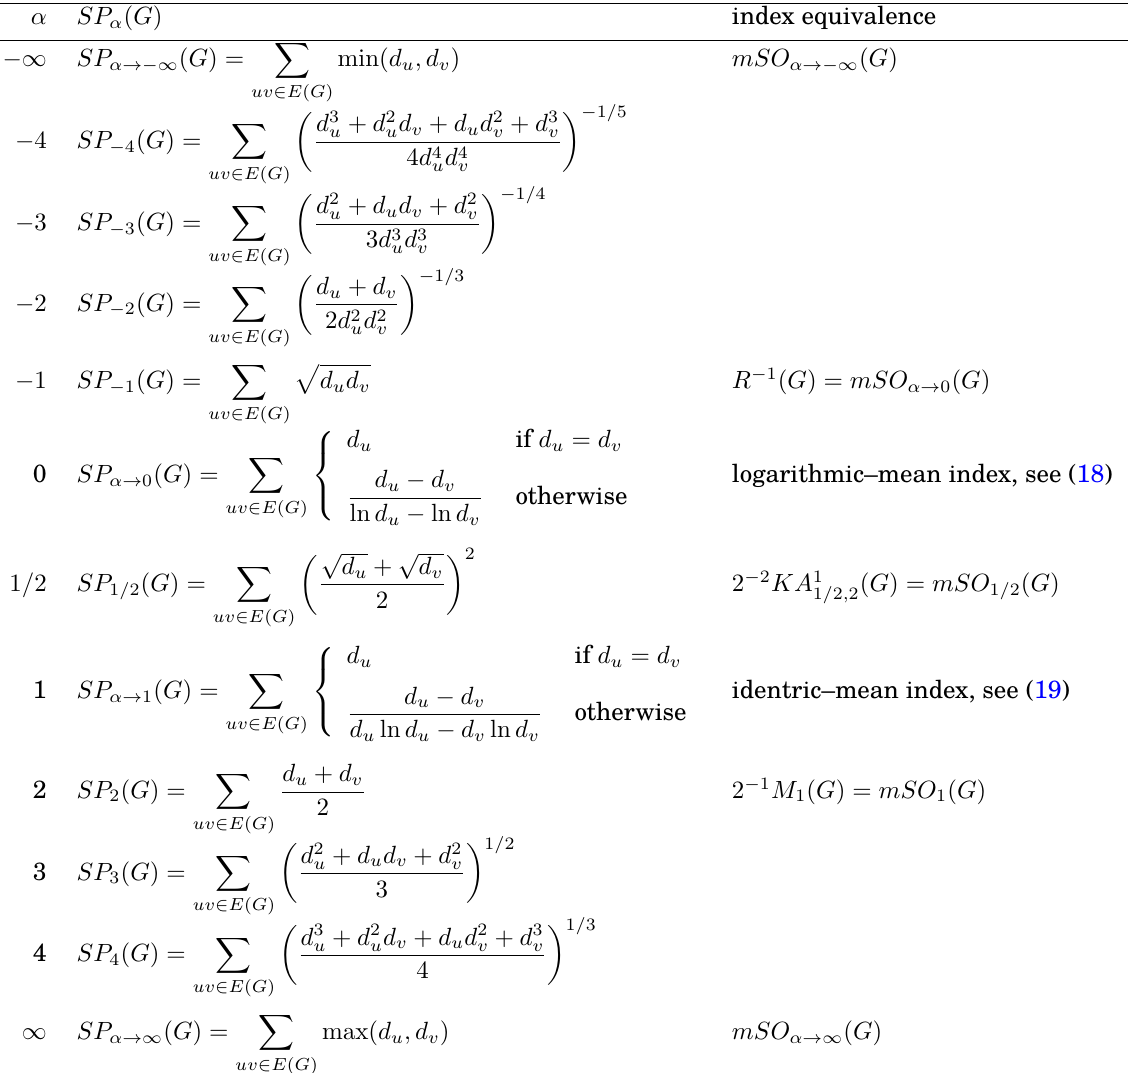
Table 2: Expressions for the Stolarsky–Puebla index SP